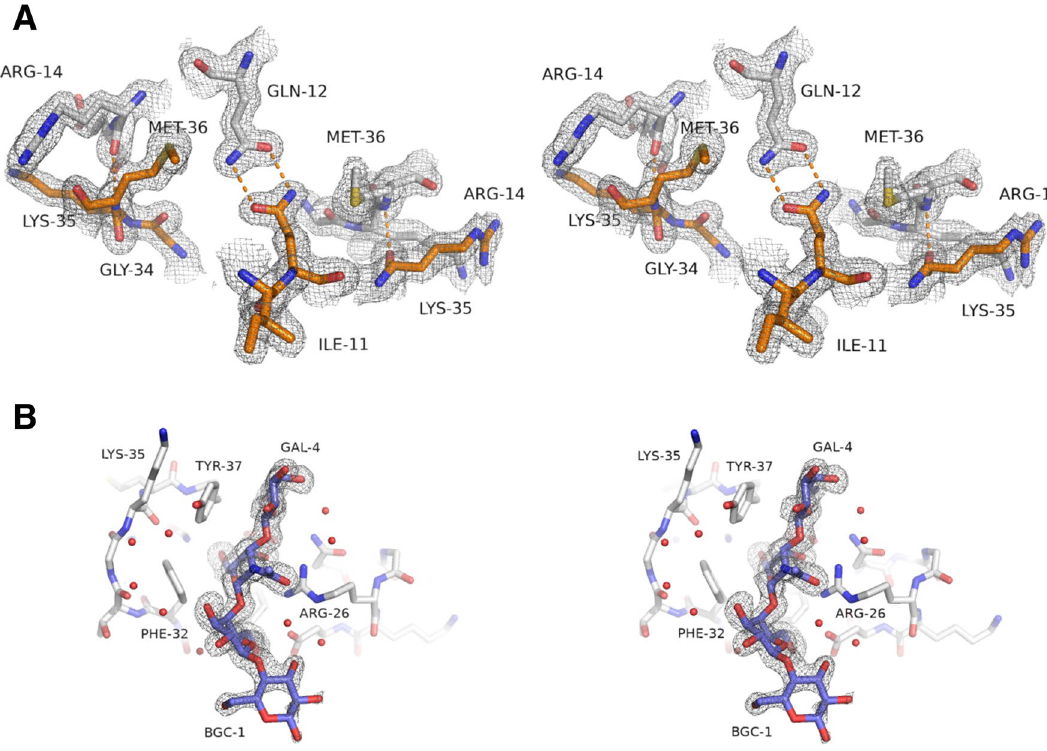
Figure 2. ( A ) Stereo view of the 2mFo-DFc electron density map of apo-SeviL, showing the dimer interface created by the two-fold symmetry axis. Carbon atoms are shown in brown for one subunit and white for the other. Oxygen atoms are coloured red and nitrogen blue. Hydrogen bonds are shown as orange dotted lines. The Gln 12 side-chain forms a double hydrogen bond with its symmetry mate. The nitrogen atom of Met 36 donates a hydrogen bond to the oxygen atom of Arg 14 in the partner subunit. The map is contoured at 1 σ . ( B ) The 2mFo-DFc electron density map covering the tetrasaccharide bound by SeviL. The glucose residue is more mobile, but the temperature factors and density for the other residues indicate high occupancy in a single